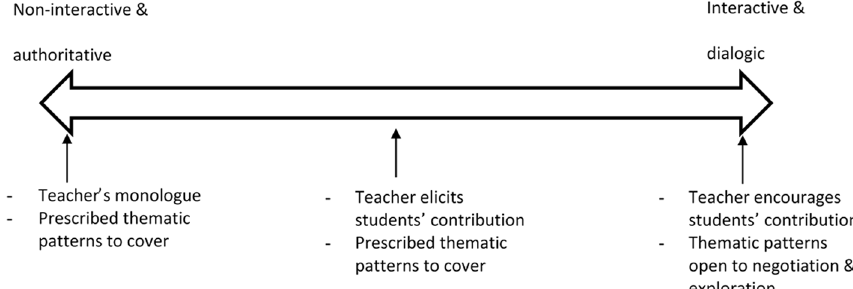
Fig. 1 A continuum for understanding teacher–student interactions. ( Source : adapted from Lin & Lo, 2017: 42, Fig. 2, reprinted with